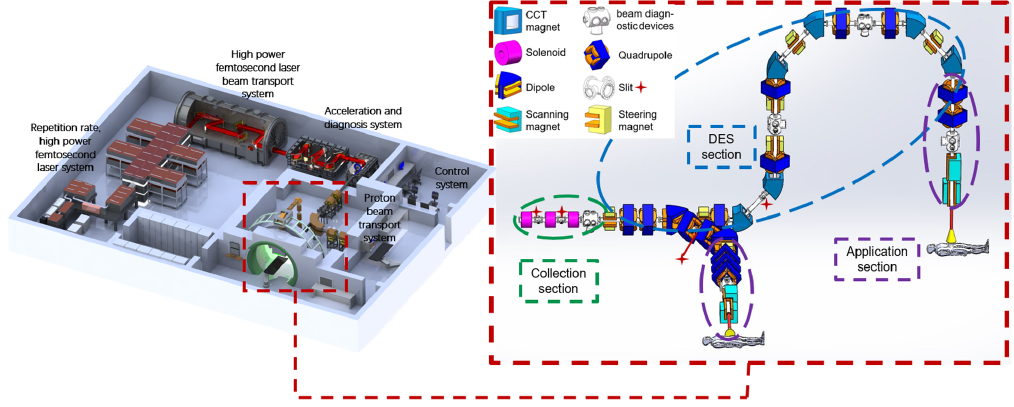
FIG. 1. Layout of CLAPA-T and its transport system. The overall layout of the beam transport system is in the red dotted box. Different sections of the beam transport system are circled by dashed lines of different